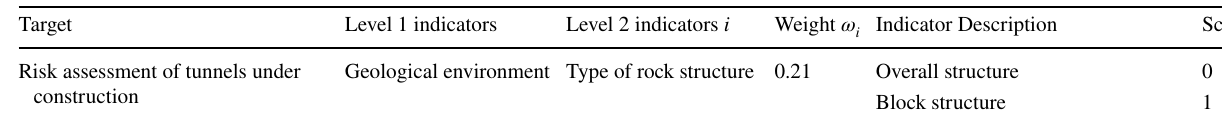
Table 1 Risk evaluation indicators and scoring standards of tunnels under construction